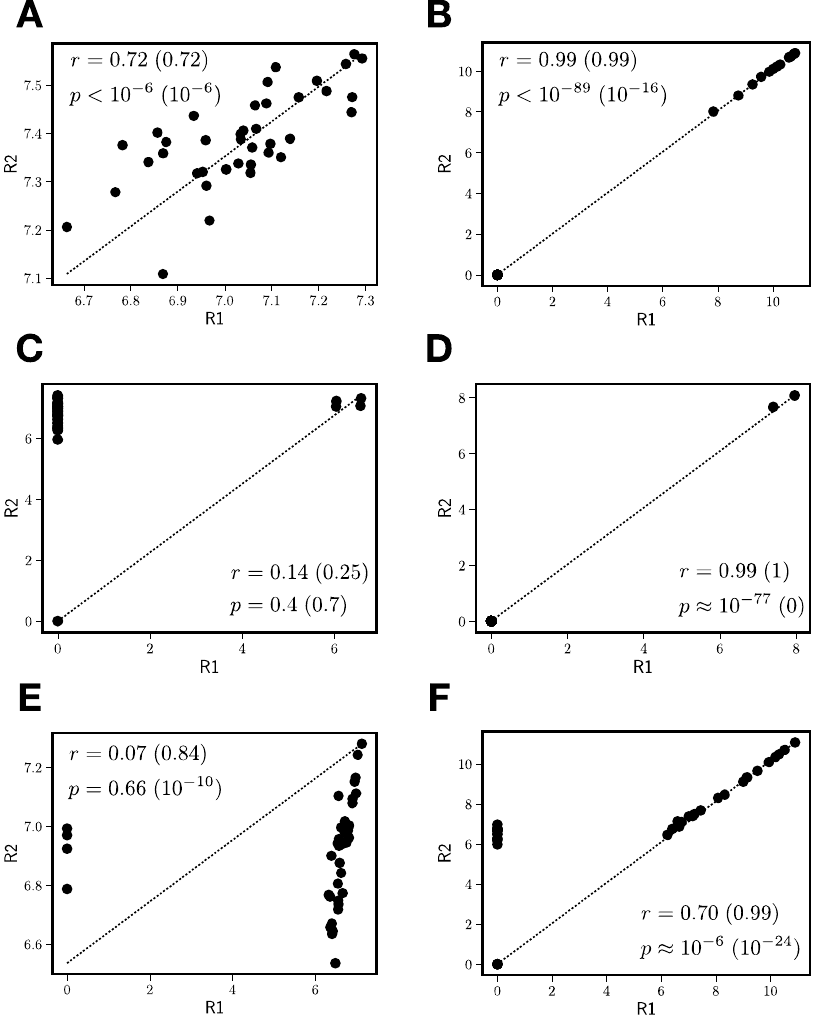
Figure 3. Log of one plus peak intensity, plotted for six different peaks ( A – F ) with one replicate (R1) plotted against another (R2). ( A – C ) All denote non-problematic peaks for “naïve” reproducibility filtering. ( D ) Denotes a peak with artifactually high correlation, and ( E , F ) show peaks that would be differentially selected based on standard versus zero-censored cross-replicate correlation calculations. Diagonal lines indicate perfect